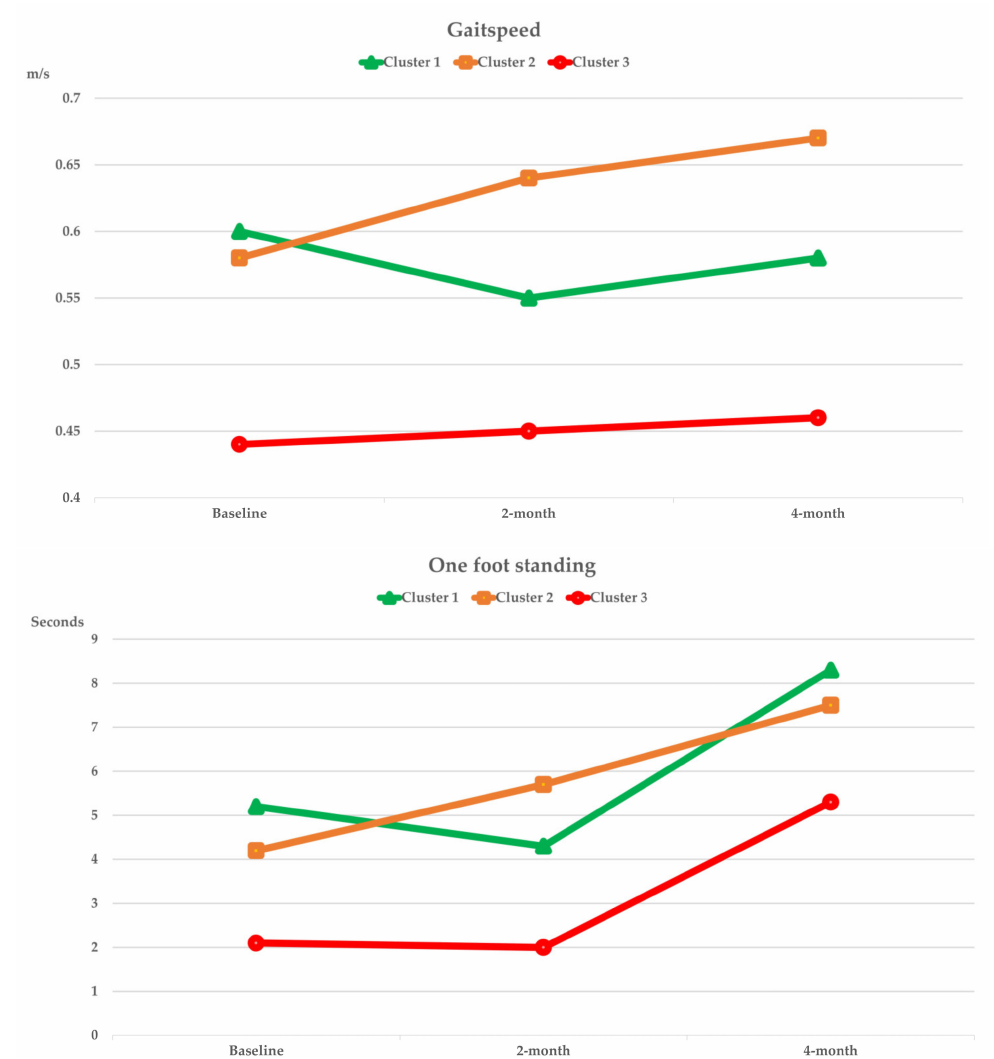
Figure 5. Curve chart for the within cluster comparison of median of intrinsic capacity in locomotion captured by GS and OFS at two-month and four-month of intervention. GS, gaitspeed; OFS, One foot standing